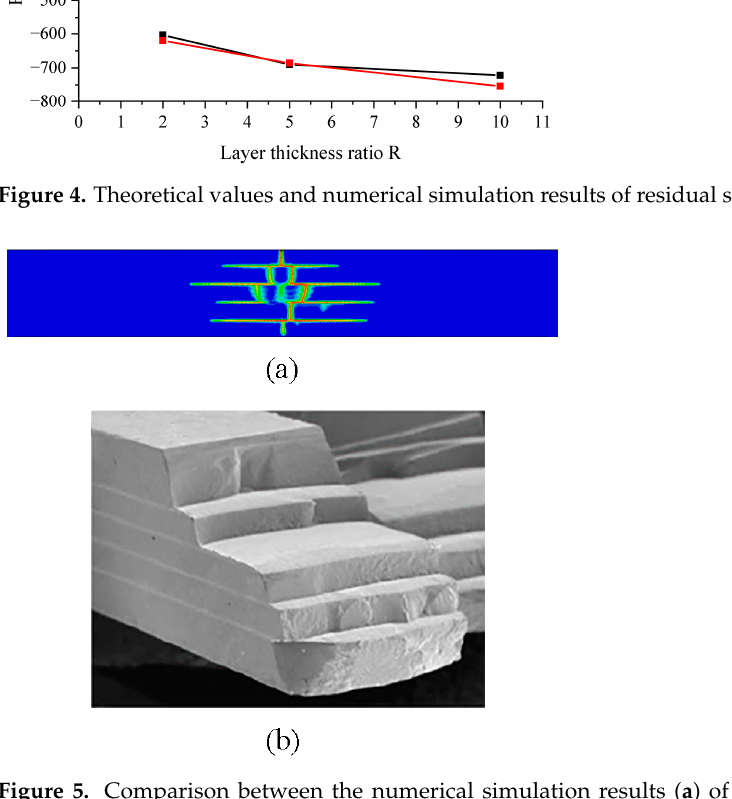
Figure 6. Stress distribution in the Y-direction of different layer thickness ratio models (( a ) R = 2, ( b ) R = 5, and ( c ) R = 10).